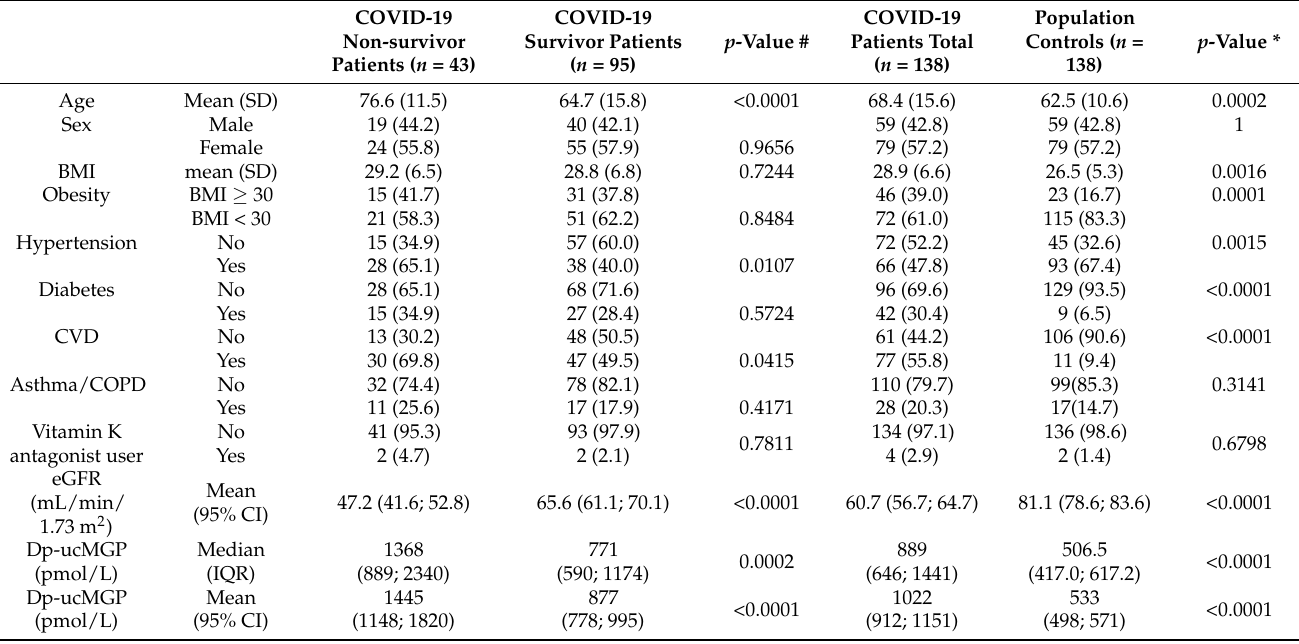
BMI: body mass index; CVD: cardiovascular disease; COPD: chronic obstructive pulmonary disease; IQR: interquartile range; SD: standard deviation; Dp-ucMGP: Dephosphorylated and uncarboxylated Matrix Gla Protein; eGFR: estimated Glomerular Filtration Rate. # p -value for comparison of non-survivor and survivor patients using X2 tests, Fisher’s exact test, t -test, or Mann–Whitney U test as appropriate. * p -value for comparison of patients ( n = 138) and sex- and age-matched controls (138) using X2 tests, Fisher’s exact test, t -test, or Mann–Whitney U test as